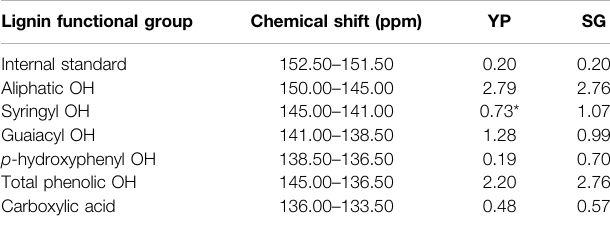
TABLE 1 | Hydroxyl group contents of YP and SG lignin samples obtained by 31 P